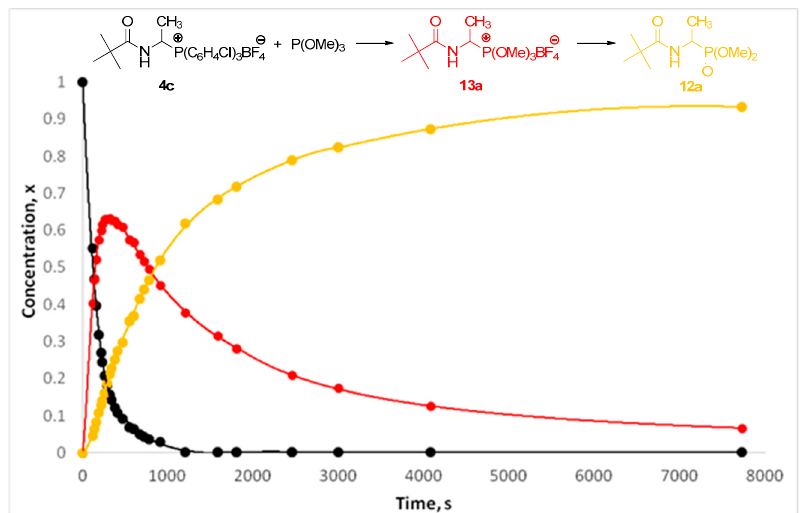
Figure 1. Concentration of the substrate 4c , intermediate 13a , and product 12a as a function of time for the reaction of 1-( N -pivaloylamino)ethyltris(3-chlorophenyl)phosphonium tetrafluoroborate ( 4c ) with trimethyl phosphite at 26 °C.